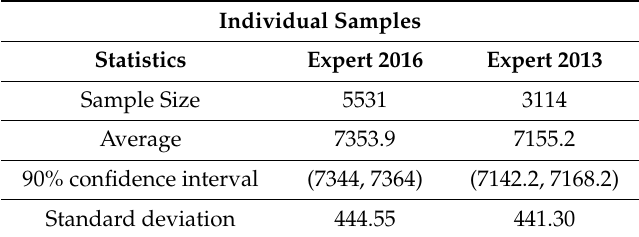
Table 10. Hypothesis test, expert system K-UCN vs. Expert System 2013.